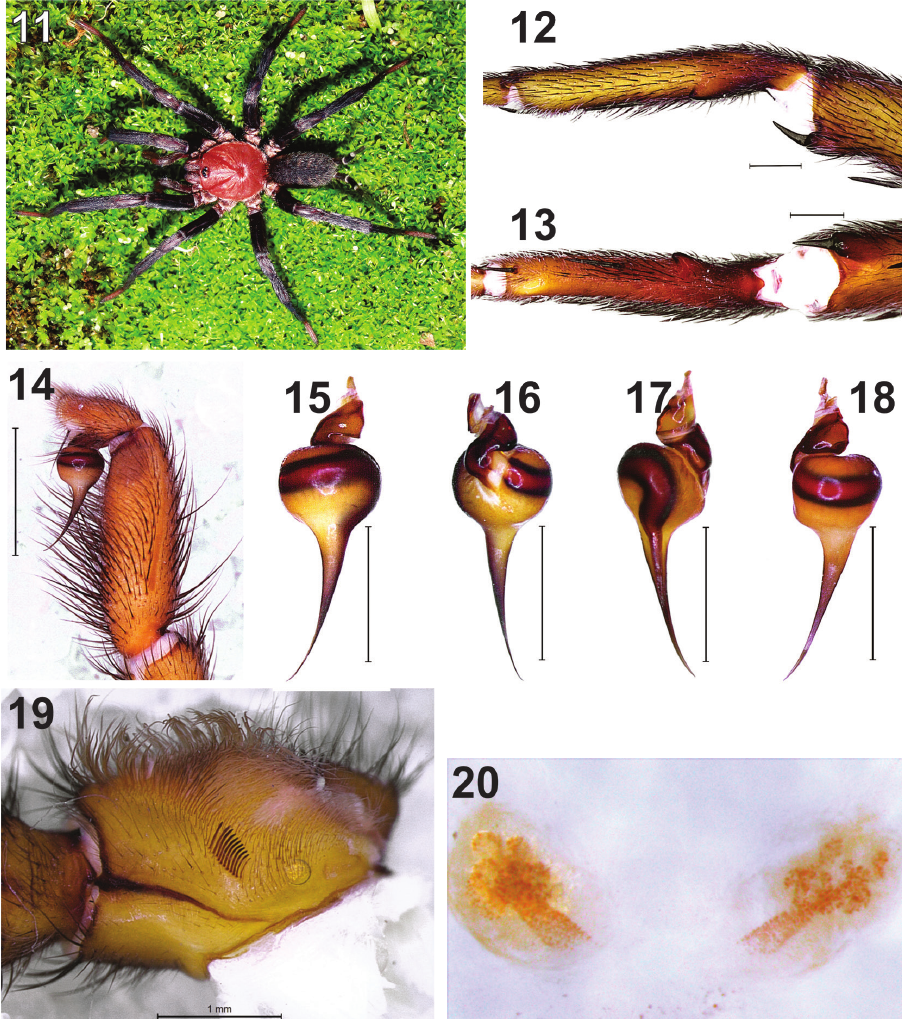
Figures 11–20. Diplura rodrigoi sp. n. Juvenile: 11 habitus dorsal (Porto Velho-RO, photo R. Indicat- ti). Male: left leg I 12 tibial spur, retrolateral 13 tibial spur and metatarsal clasper, ventral 14 left palp, retrolateral; left bulb 15 retrolateral 16 prolateral 17 ventral 18 dorsal 19 maxilla with lyra. Female: 20 receptaculum seminis